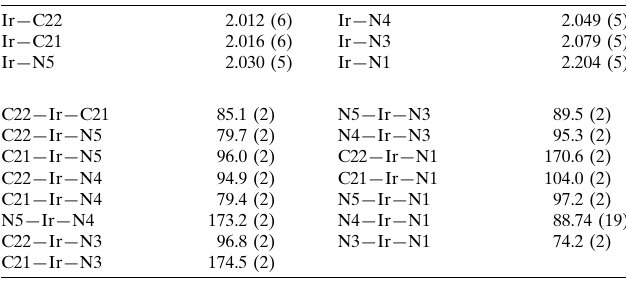
Selected geometric parameters (A˚ , (cid:1)